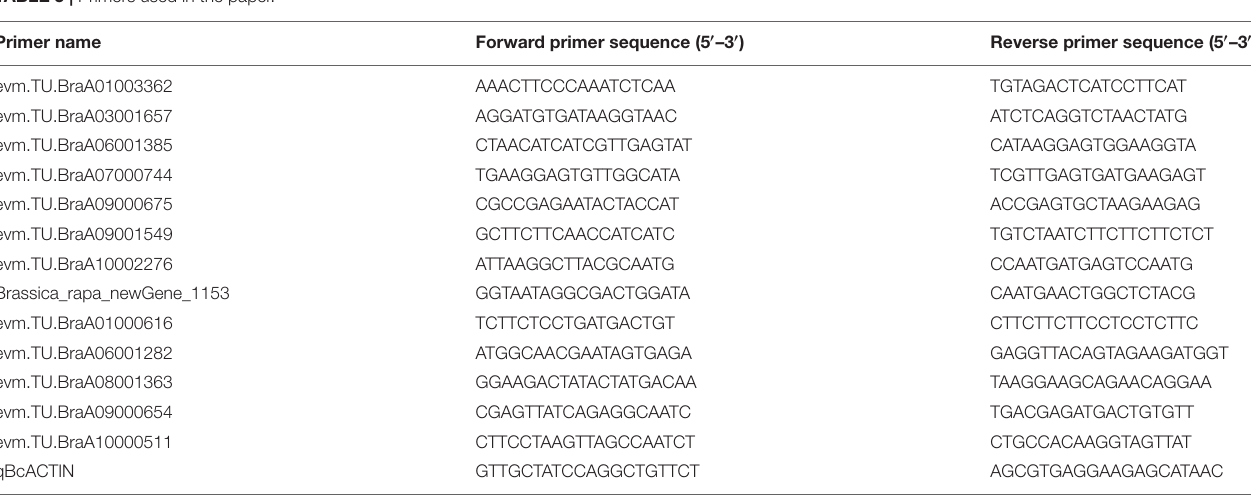
TABLE 5 | Primers used in the